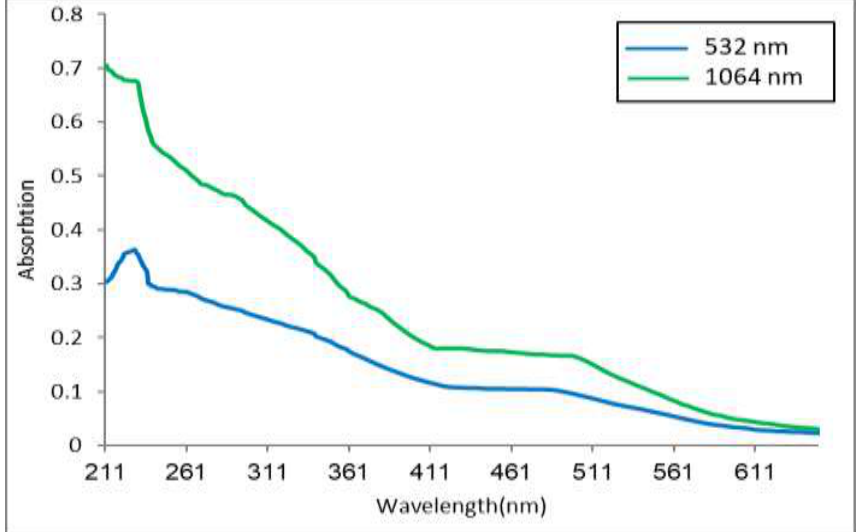
Figure 1. Fe@Au NPs colloidal in DDW absorption spectra at different laser